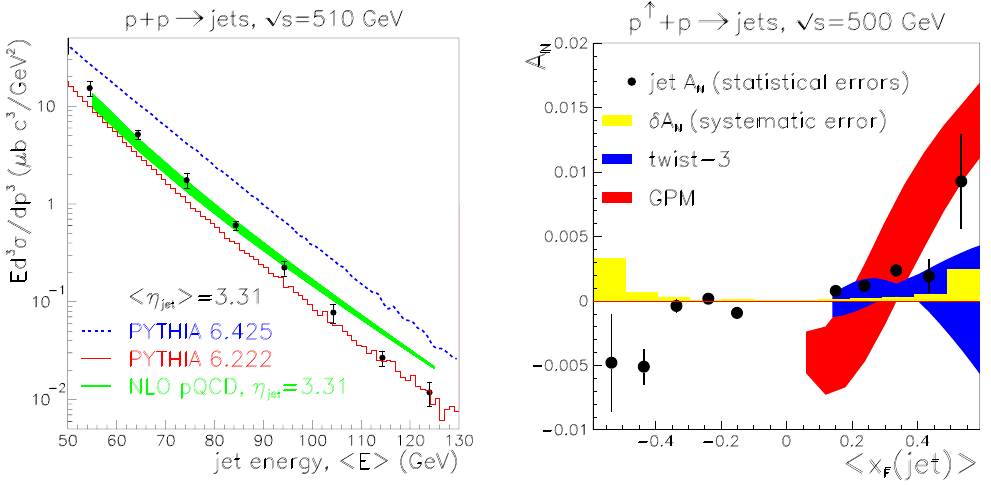
√ s = 510 GeV, in comparison to NLO pQCD and